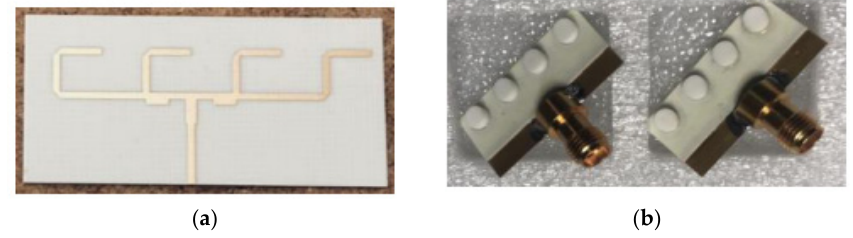
Figure 23. Fabricated cylindrical DRA array: ( a ) feed network; ( b ) array [97].